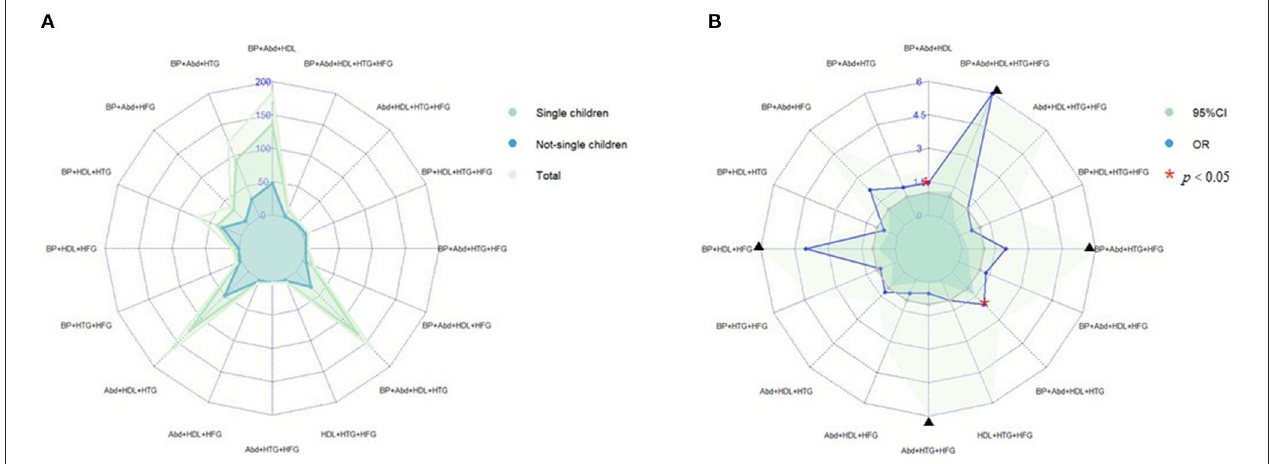
FIGURE 1 | (A) Prevalence of various components of MS among single and not-single children. (B) Risk of various components of MS among single and not-single children. BP, Elevated blood pressure; Abd, Abdominal obesity; HDL, Low HDL-C; HTG, Hypertriglyceridemia; HFG, High fasting glucose. N Represents 95% confidence interval is over